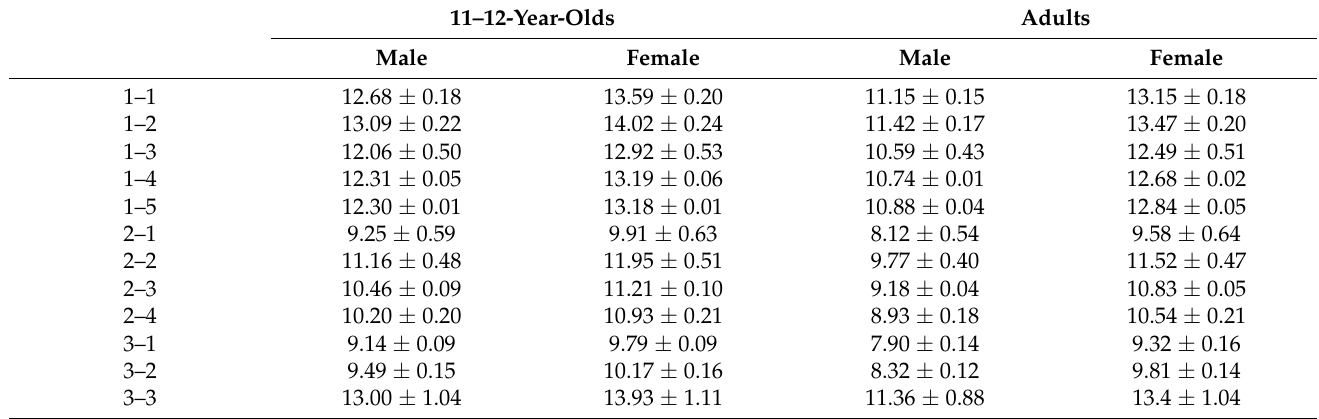
Table 15. The degree of matching (DM) in fresh corn from the three